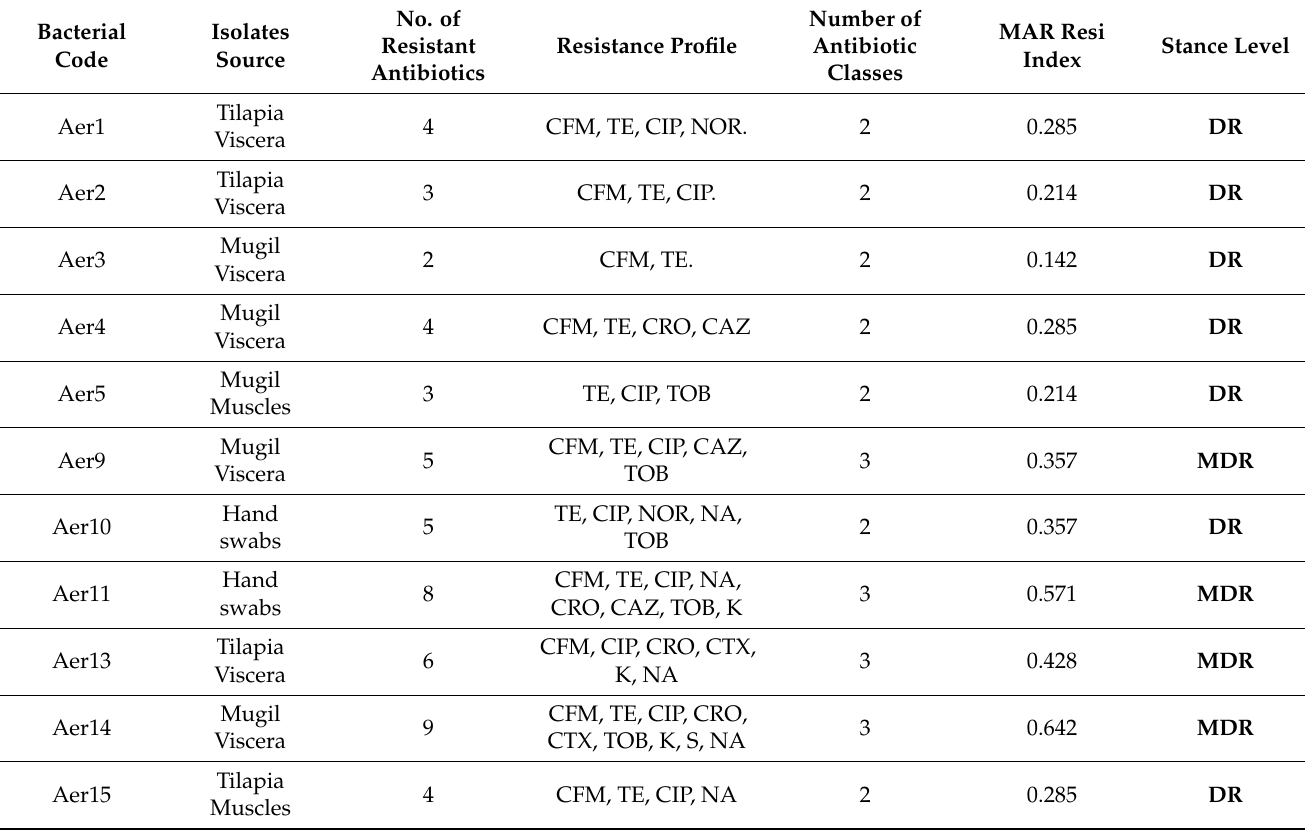
Table 5. Distribution of antibiotic resistance (%) of Aeromonas spp. isolates and MAR